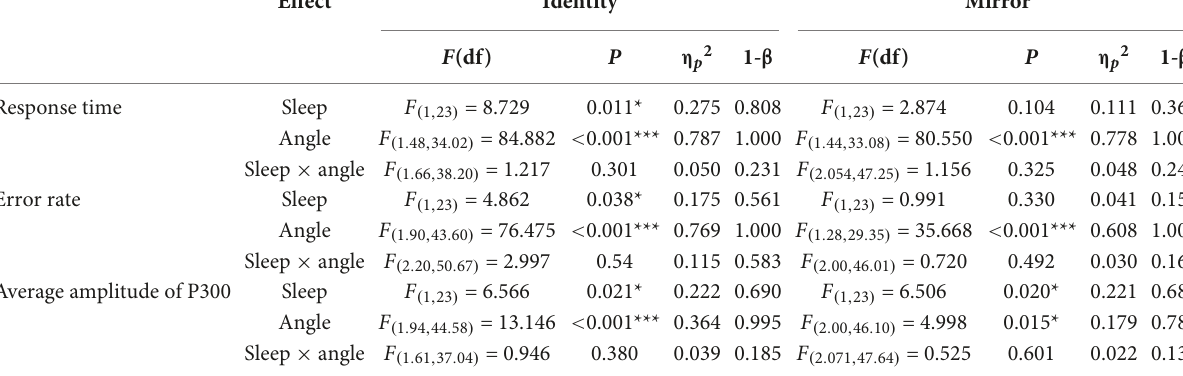
TABLE 4 ANOVA statistic for behavioral (response time and error rate) and ERP data (Average amplitude of